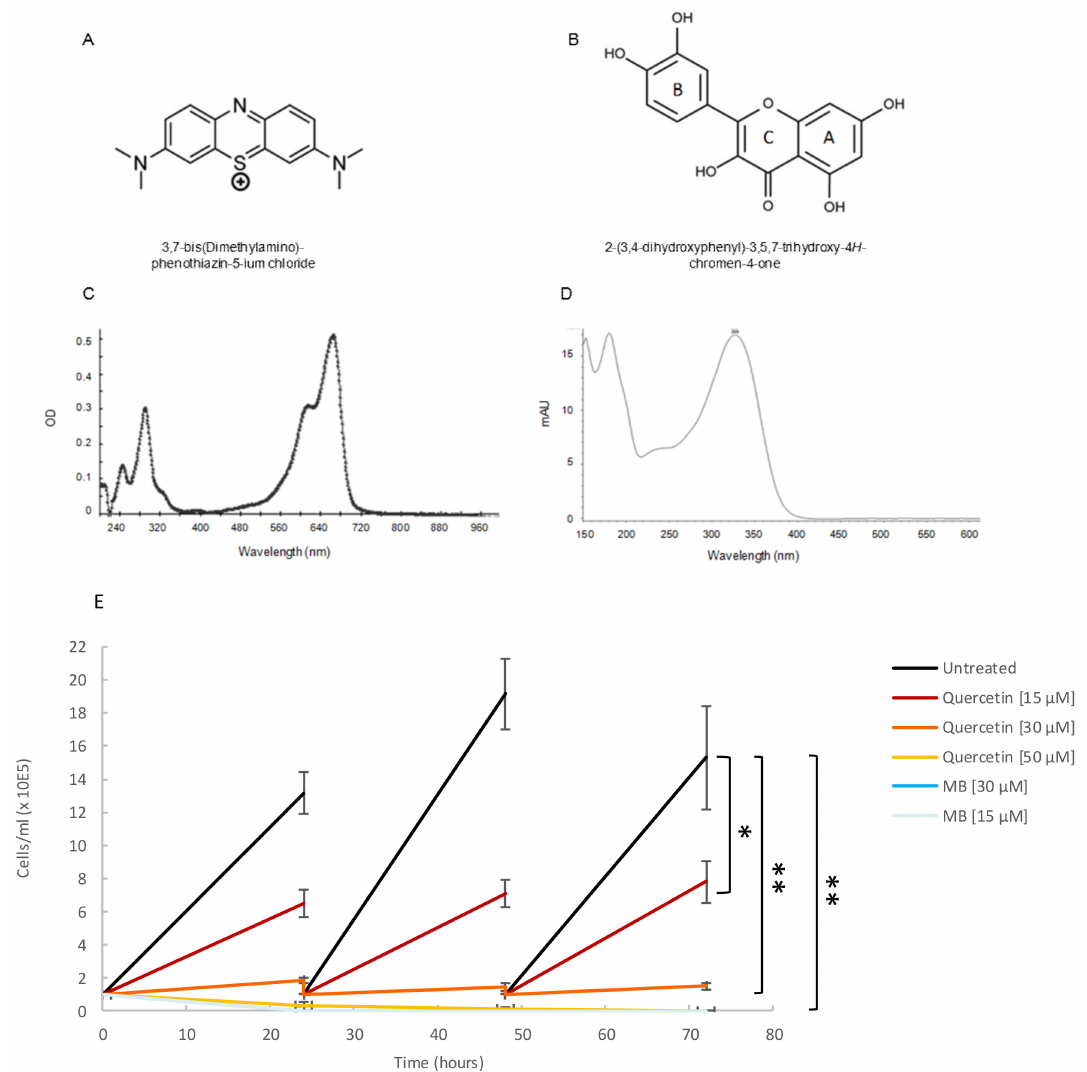
Figure 7. Quercetin and methylene blue inhibits growth of the bloodstream form of T. brucei. ( A ) Tetramethylthionine, commonly called methylene blue (MB), is a phenothiazine: a heterocyclic aromatic compound consisting of two benzene rings, each with a methylamino group, adjacent to a single thiazine. ( B ) Natural flavonoid quercetin. ( C ) A spectral scan of MB (30 µ M) suspended in assay buffer revealed a UV visible spectrum at A290 nm and another at A665 nm. ( D ) A spectral scan of quercetin resulted in a UV-visible spectrum at A369 nm. ( E ) The phenotypic effect of quercetin (15 µ M; 30 µ M; 50 µ M), and MB (15 µ M; 30 µ M) on T. brucei cells was assessed by means of growth curve analysis. The Y-axis represents 1 × 10 5 cells/mL and the X-axis the duration of the experiment, in hours. The error bars were generated from data obtained using independent T. brucei cell preparations. Statistical significance was determined by using one-way ANOVA and post-hoc test (* p < 0.01; ** p <